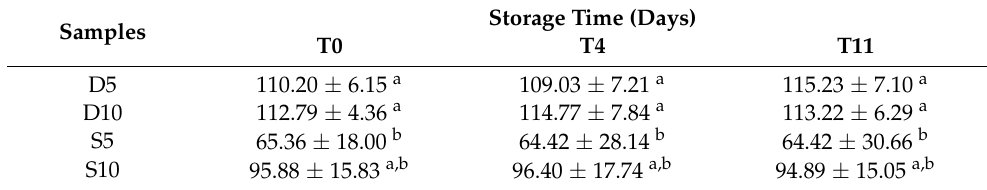
Figure 2. Micrographs of sections of coated fresh-cut melon samples (C = control, S5 = Sprayed with 5% coating; S10 = Sprayed with 10% coating; D5 = Dipped with 5% coating; D10 = Dipped with 10% coating) at 0, 4 and 11 days of refrigerated storage. Table 3. Coating thickness ( µ m) obtained from the microscopic examination of the cross-linking section of fresh-cut melon samples during 0, 4, 11 days of storage.